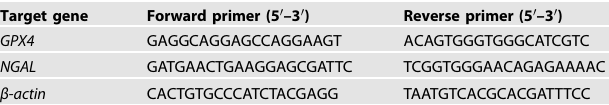
Table 1. Sequences of primer pairs used for gene ampli fi cation in this